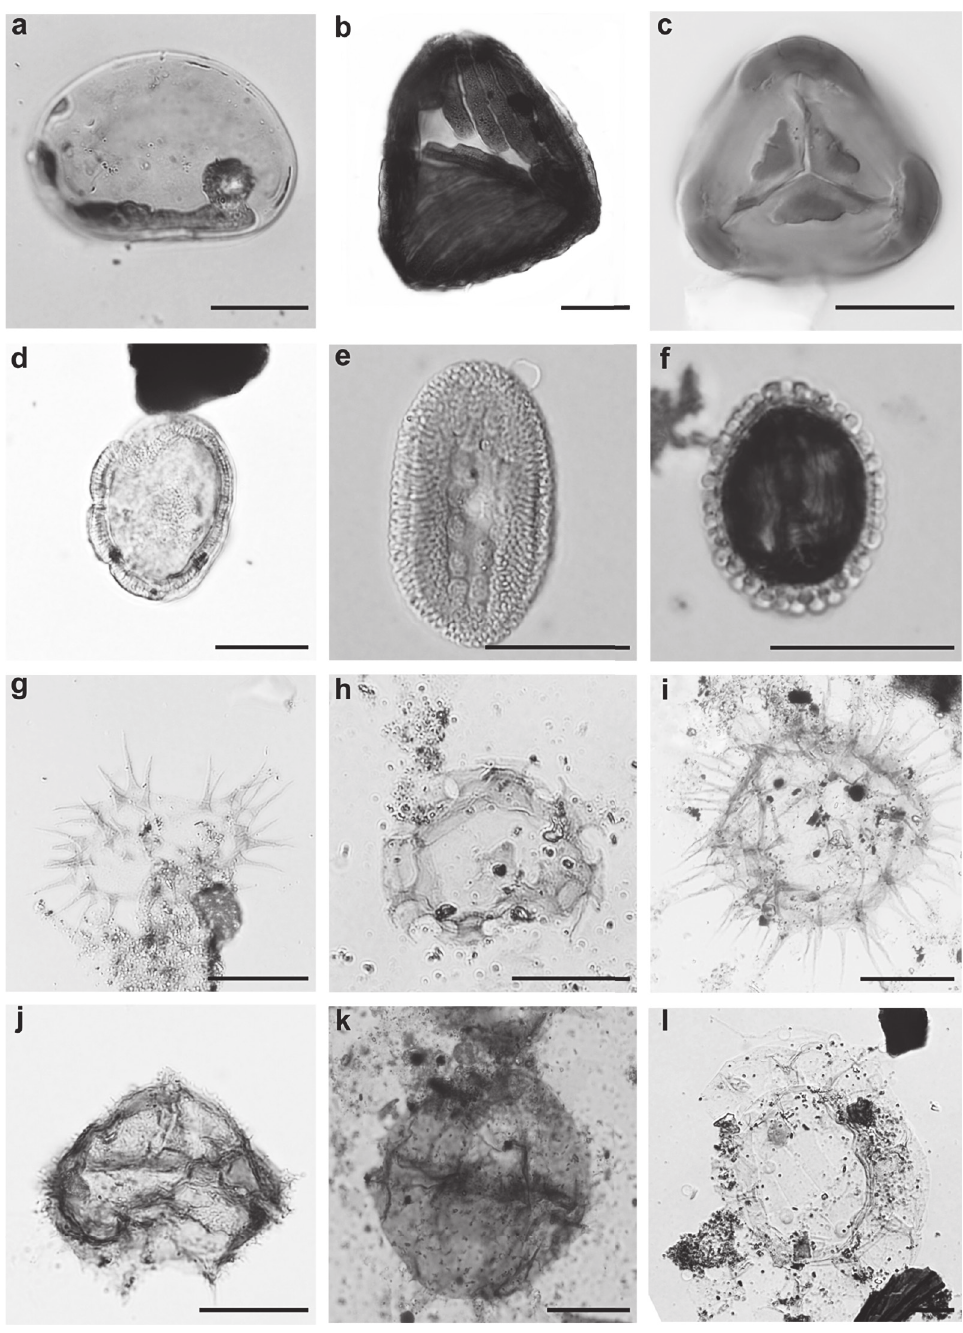
Fig. 3 - Selected palynomorphs recorded from well 2-TG-96-RS. (a) Laevigatosporites vulgaris (slide MP-P 5425; England Finder coordinate: N40-4); (b) Cicatricosisporites sp. 2 (5454; W60-1); (c) Cyatheacidites annulatus (5446; L56); (d) Retistephanocolpites gracilis (5403; T41-4); ( e) Multiareolites formosus (5423; D30-1); (f) Ilexpollenites sp. (5431; M42-1); (g) Quadrina ? condita (5430; P30-3); (h) Selenopemphix armageddonensis (5452; N40); (i) Selenopemphix quanta (5617; K35-2); (j) Trinovantedinium glorianum (5423; O37-3); (k) Capillicysta fusca (5448; O57); (l) Tuberculodinium vancampoae (5414; P38). The scale bars represent 20